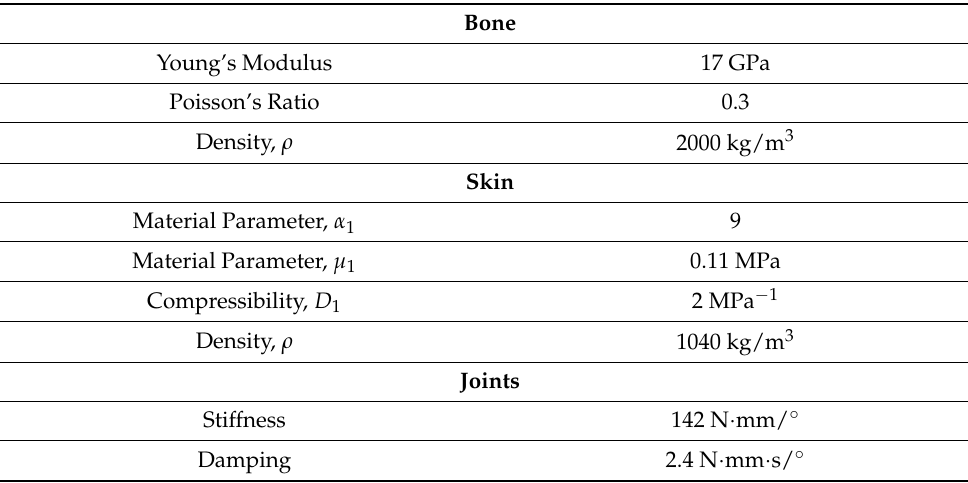
Table 1. Material properties of human hand bone and soft tissue. Bone Young’s Modulus 17